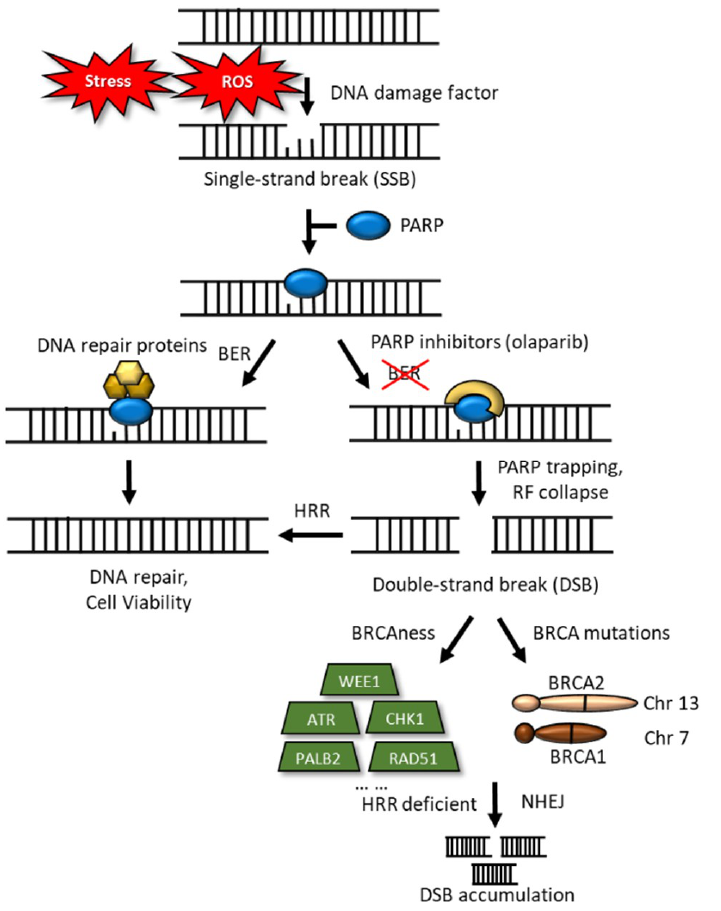
Figure 3. Schematic representation of DNA damage and DNA-double-strand breaks. DNA-damage inducers, such as stress and ROS, sometimes trigger single-strand breaks (SSBs), to which PARP binds, for their repair. Base excision repair (BER) reverses the DNA damage resulting from oxidation, deamination, and alkylation. In this case, BER DNA glycosylase recognizes and removes the damaged base, leaving an abasic site that is processed further, by short-patch or long-patch repair, which largely uses different proteins to complete BER. PARP inhibitors trap the PARP-1 protein at an SSB/DNA lesion and disrupt its catalytic cycle, this would ultimately lead to replication fork progression and consequent double-strand breaks (DSBs). In the case of BRCA mutations, loss of HRR would result in cell death. HRR deficient and nonhomologous end-joining lead to the accumulation of DSBs.